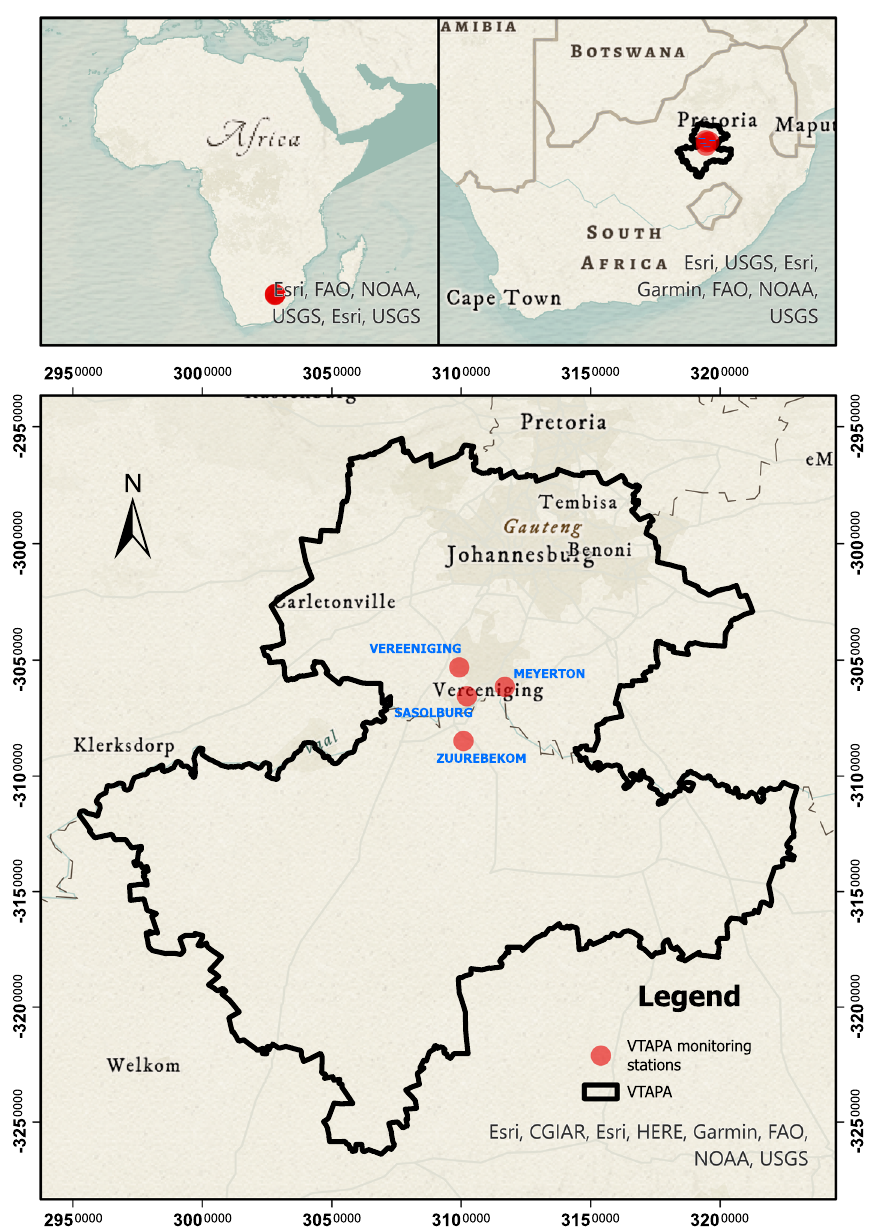
Figure 4. Geographic location of the study area (Vaal Triangle region) in South Africa. Map produced using ArcGIS Pro 2.9 (https:// pro. arcgis. com/ en/ pro- app/2. 9/ get- start ed/ get- start ed.